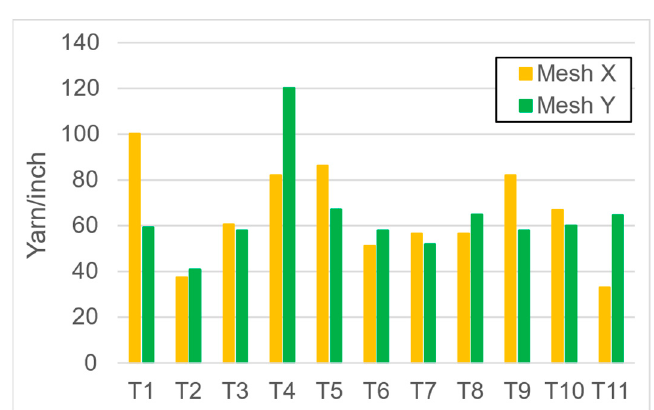
Figure 2. Measured mesh numbers on T1-T11 samples.